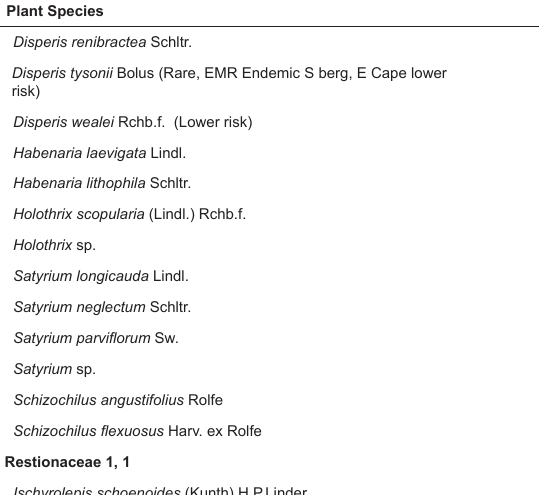
Melinis nerviglumis (Franch.) Zizka Merxmuellera drakensbergensis (Schweick.) Conert Merxmuellera sp.